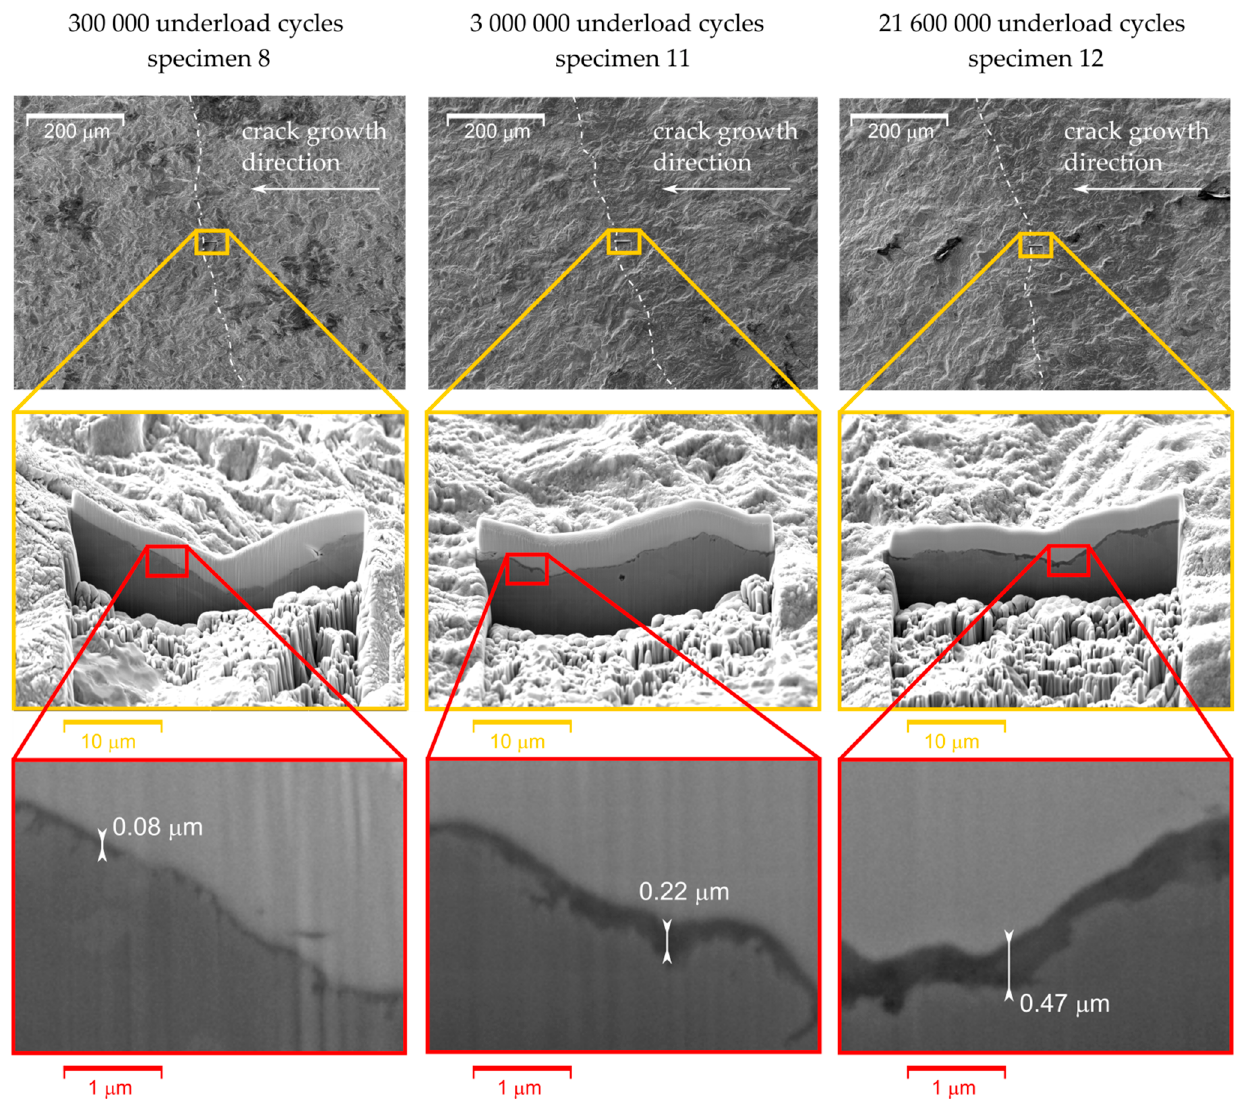
Figure 16. Focused ion beam (FIB) cuts of the selected specimens with highlighted thicknesses of the oxide layers. The position of the actual crack front at the time of application of the underload cycles is marked by the white dash-dotted curve in the top images.